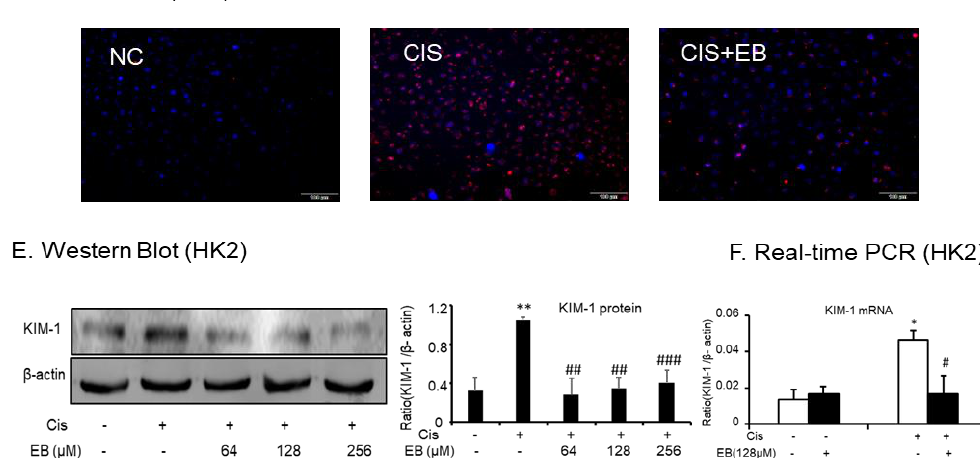
Figure 1. Effect of eleutheroside B on cell viability and kidney injury molecule-1 (KIM-1) levels with or without cisplatin treatment. ( A ) Molecular structure of eleutheroside B. ( B ) Effect of different concentrations of eleutheroside B on viability of human kidney-2 (HK-2) cells by MTT assay. ( C ) Eleutheroside B restored cell viability in cisplatin-treated HK-2 cells by MTT assay. ( D ) Immunofluorescence of KIM-1 in HK-2 cells. Eleutheroside B treatment significantly reduced the protein level of KIM-1 in cisplatin-treated HK-2 cells. ( E ) Western blot analysis of KIM-1 protein in HK-2 cells. ( F ) Real-time PCR in HK-2 cells. Eleutheroside B significantly decreased cisplatin-induced mRNA level of KIM-1. Data represent the mean ± SEM for 3 – 4 independent experiments in vitro. ** p < 0.05, ** p < 0.01, *** p < 0.001 versus normal; # p < 0.05, ## p < 0.01, ### p < 0.001 compared to cisplatin-treated group. Cis, cisplatin.